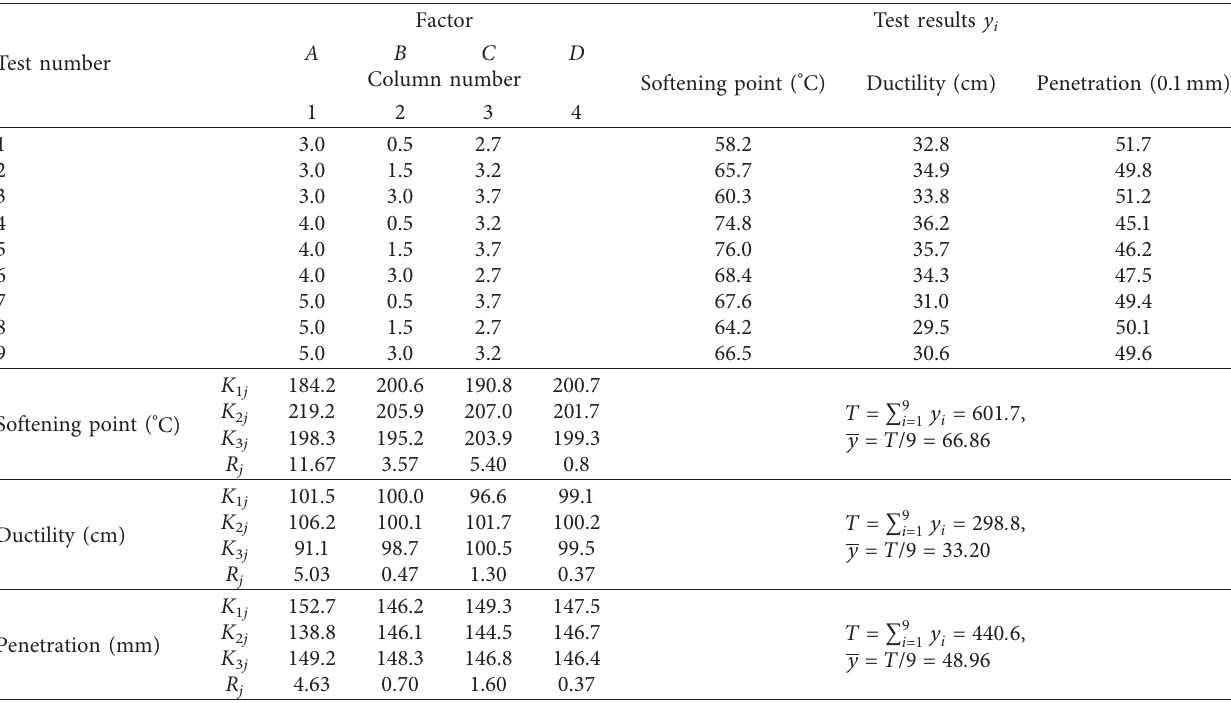
Table 6: Test results and calculation